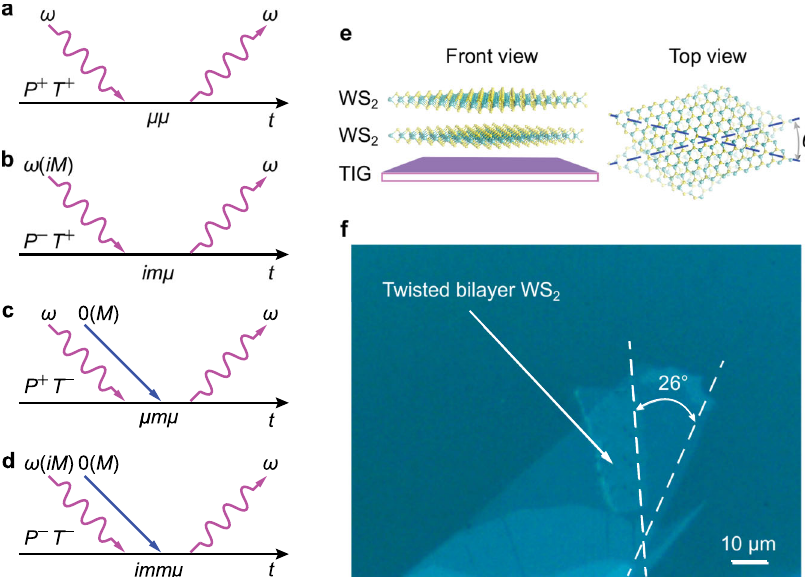
Fig. 1 Light-matter interactions in chiral media. a – d Multipolar light-matter interactions with symmetry analysis. The horizontal axis is the time ( t ), and the arrows are light waves (purple) at the frequency of ω and a static magnetic fi eld (blue), correspondingly. In a comment medium a electric dipole interactions ( μμ ) generally dominate light-matter interaction processes, in which the parity-inversion ( P ) and time-reversal symmetry ( T ) are both conserved ( + ). The breaking of parity-inversion symmetry ( P − ) in a chiral material ( b ) leads to magnetic dipoles ( m ) interacting with electric dipoles ( μ ) while keeping the time-reversal symmetry conserved ( im ). An external magnetic fi eld breaks the time-reversal symmetry and introduces magnetic dipoles in a general material. c By breaking both the two symmetries simultaneously ( P − T − ), a second-order product ( imm μ ), or so-called magneto-chiral (MCh) effect, stands out in a chiral medium in the presence of a static magnetic fi eld ( d ). e Schematic shows that stacking two tungsten disul fi de monolayers with a twist ( θ ) offers a chirality and the ferromagnetic thulium iron garnet (TIG) provides an exchange magnetic fi eld. f Optical images of a twisted bilayer tungsten disul fi de (TB-WS 2 ) with the twisting angle of 26° on the TIG. The scale bar represents a length of 10 μ m.